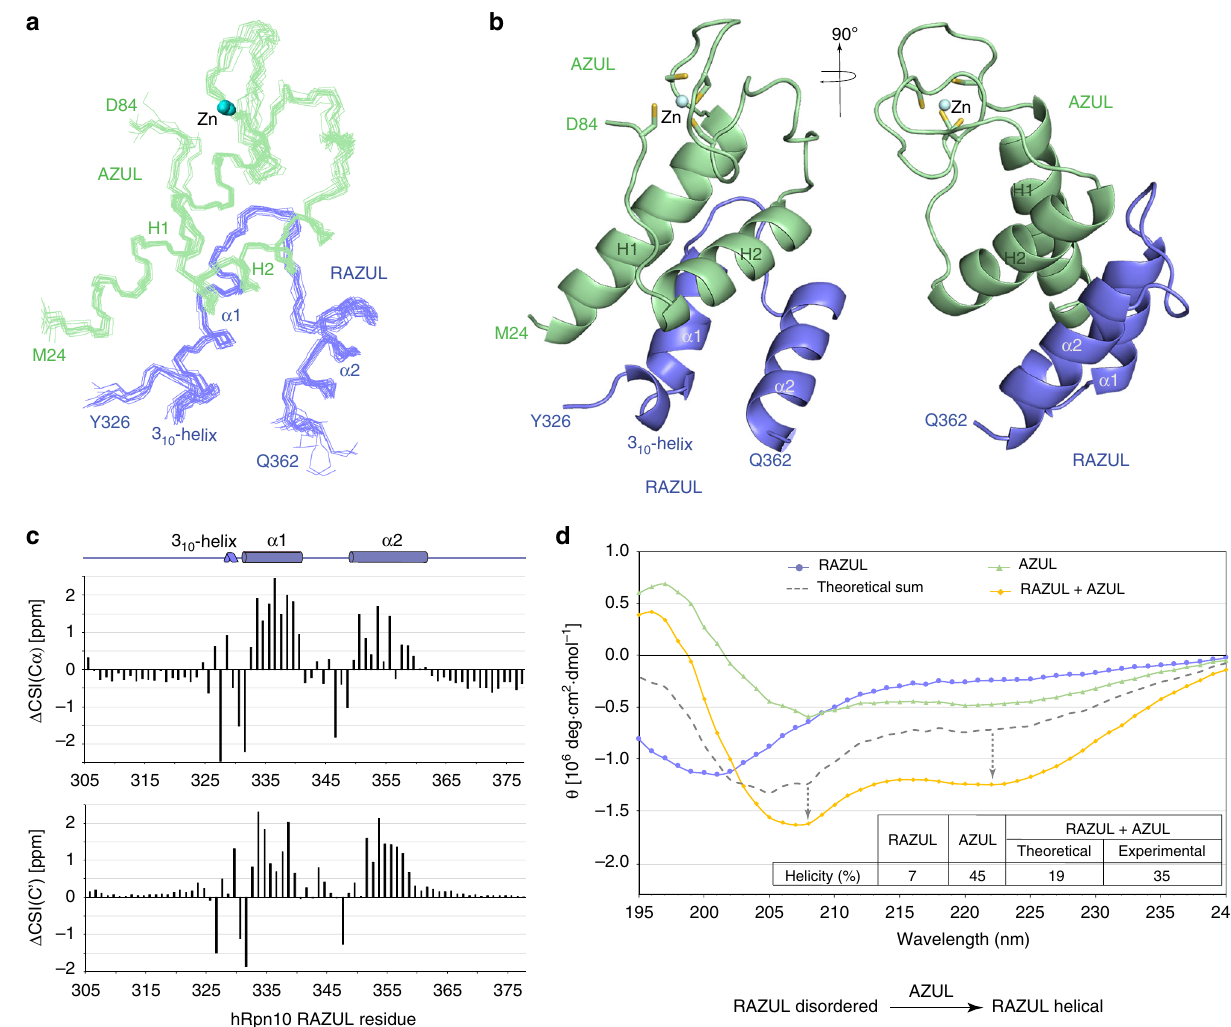
Fig. 5 AZUL induces helicity in hRpn10 RAZUL. a Backbone trace labeling terminal residues of 15 lowest energy RAZUL (blue):AZUL (green) structures superimposing secondary structures with Zn displayed (blue sphere). Secondary structures and Zn are labeled in a , b . b Representative ribbon diagram of the RAZUL:AZUL structure with sidechain atoms of Zn-coordinating cysteines displayed as sticks with sulfur yellow. c AZUL-induced CSI change ( Δ CSI) for RAZUL C α (top) and C ’ (bottom). Δ CSI(C α ) = CSI(C α bound ) − CSI(C α free ); Δ CSI(C ’ ) = CSI(C ’ bound ) − CSI(C ’ free ). d CD spectra of RAZUL (blue), AZUL (green), and the mixture (orange). The theoretical sum spectrum based on free values (gray) is displayed, with a table listing predicted helicity and schematic depicting the effect of AZUL on RAZUL structure. Source data are provided as a Source Data fi